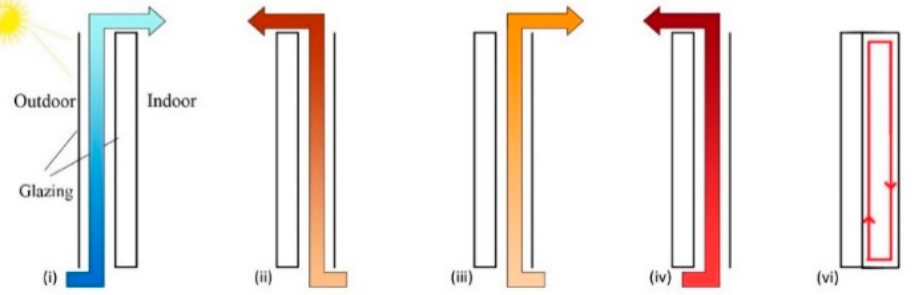
Figure 1. Schematic illustration of the principle operation modes of a ventilated window. Adapted from [8,9]. i : Supply, exhaust ii : exhaust, indoor air curtain iii : indoor air curtain, outdoor air curtain iv : outdoor air curtain, and insulation mode vi : and insulation mode According to the previous studies, condensation occurs on the outer glass pane at the cavity side when the vents operate in reverse (i.e., when indoor air enters into the cavity). vents is not sufficient to dispel the condensation from the surfaces [17]. The result of